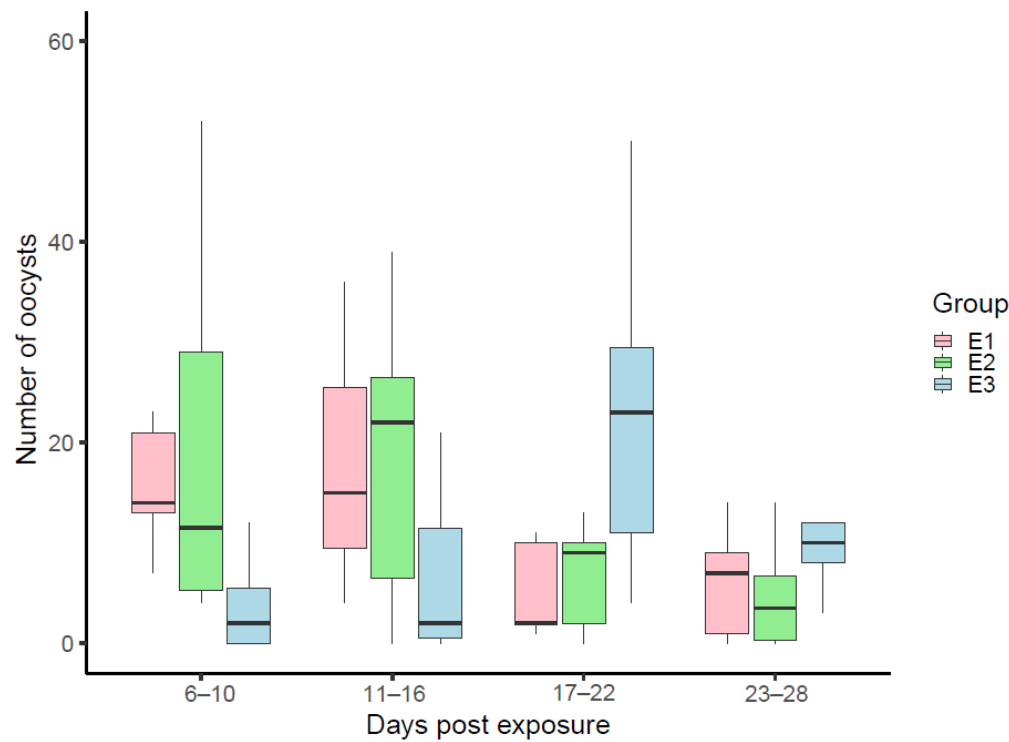
Figure 1. Numbers of Plasmodium relictum (pGRW4) oocysts in the Culex pipiens form molestus under different temperature conditions: (E1) indoors, stable day- and night-time temperature of 23 ± 1 ◦ C; (E2) natural conditions outside the biological station (average daytime temperature of 21 ◦ C and average night-time temperature of 15 ◦ C); (E3) indoors, daytime temperature of 23 ± 1 ◦ C and night-time temperature of 7 ◦